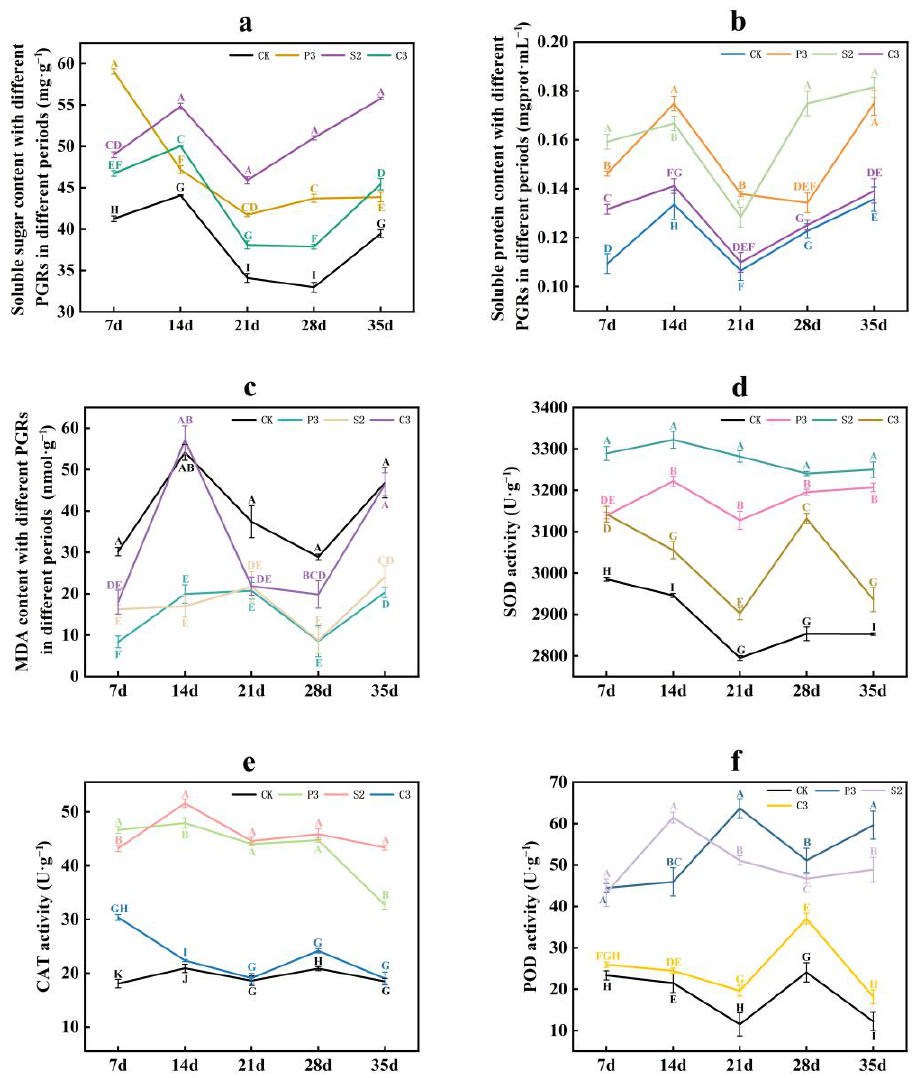
Figure 6. Effects of PGRs on physiological and biochemical indexes of M. alternifolia Leaves. ( a ) Soluble sugar content, ( b ) soluble protein content, ( c ) MDA content, ( d ) SOD activity, ( e ) CAT activity, ( f ) POD activity. Note: different letters followed the mean indicate significance at p < 0.01 according to Duncan’s multiple range test.